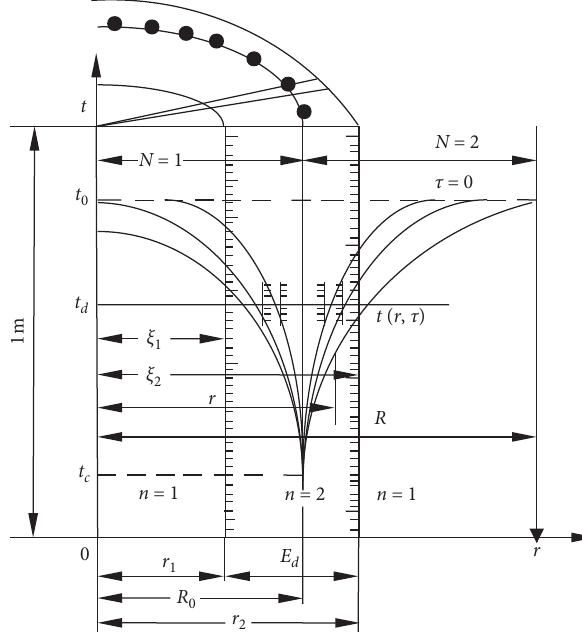
Figure 2: Freezing temperature field